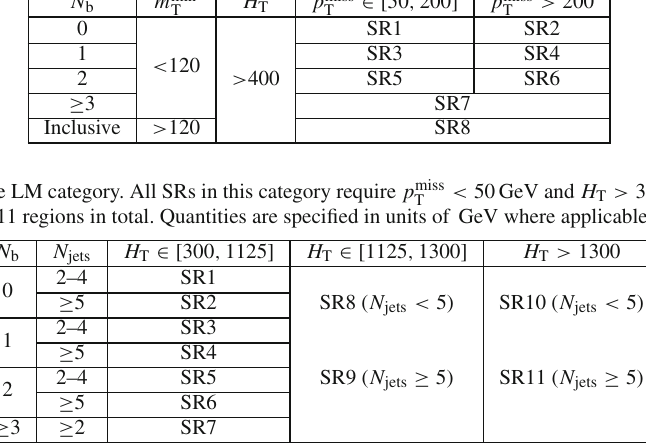
Table 4 The SR definitions for the LL category. All SRs in this category require N jets ≥ 2. There are 8 regions in total. Quantities are specified in units of GeV where applicable. N b m min T